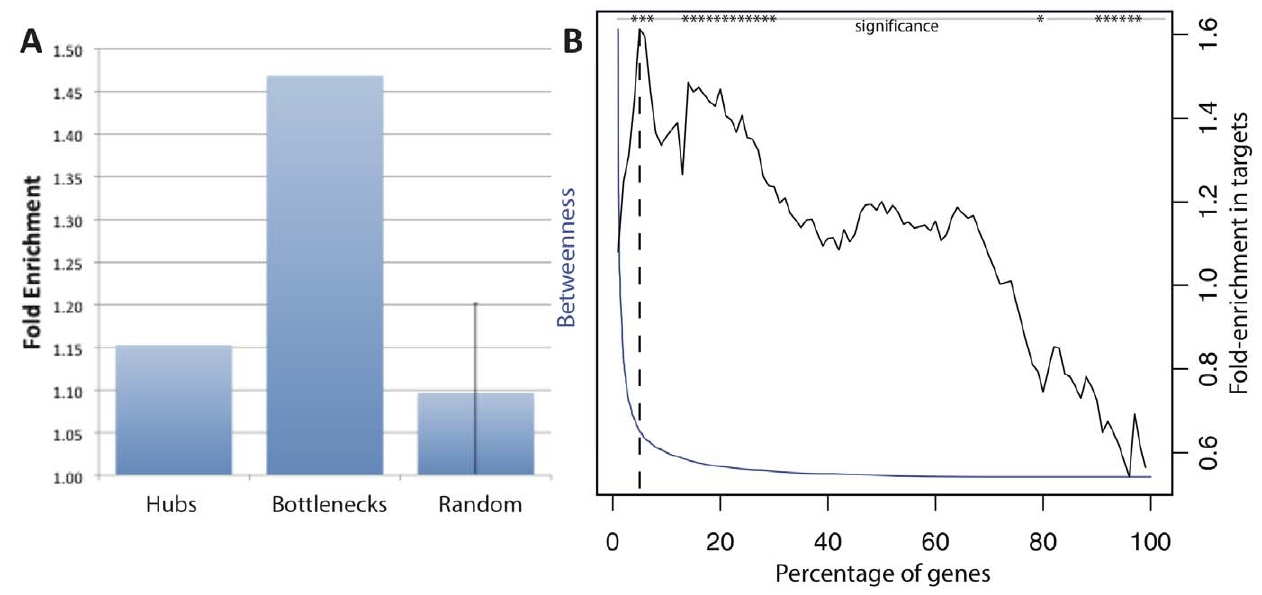
Figure 2. Topological bottlenecks in inferred networks are enriched in pathogen targets. A. Hubs and bottlenecks (top 20% of degree and betweenness values, respectively) were analyzed for their enrichment in known targets of pathogens (blue bars). Bottlenecks are significantly enriched (p-value 0.004) in pathogen targets, but not human homologs, and hubs were enriched in neither. Additionally, the mean enrichment of bottlenecks from 100 randomized networks is shown, with error bars representing + / 2 one standard deviation. B. Bottlenecks were identified using between 1 and 100% of the top ranked betweenness values in the network (x axis) and the enrichment in pathogen targets versus non-bottlenecks is shown (black line). The betweenness values are shown as a blue line. Significant fold change values (p-value , 0.05) are indicated by asterisks at the top of the figure. The dotted line indicates the location of the peak of greatest enrichment. These results indicate that bottlenecks from inferred networks are more important to the functioning of the system than other genes.